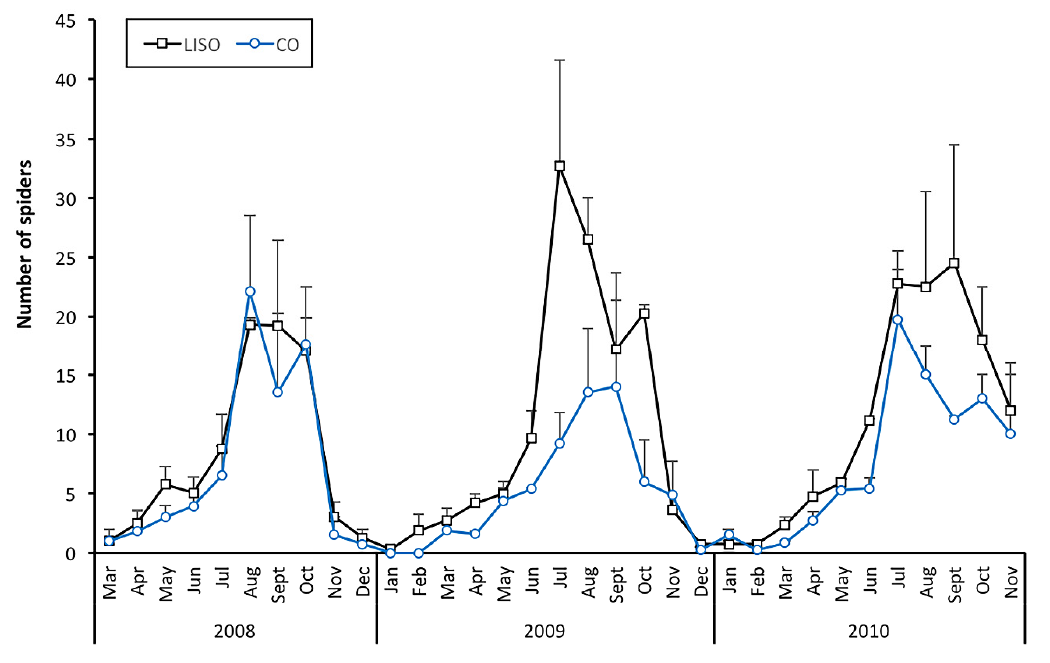
Figure 2. Monthly abundance (mean ± SE) of the number of spiders in the beating of 90 branches, collected throughout the period of study in orchards with two different intensity of spraying (LISO: low-intensity spraying orchards; CO: conventional orchards).